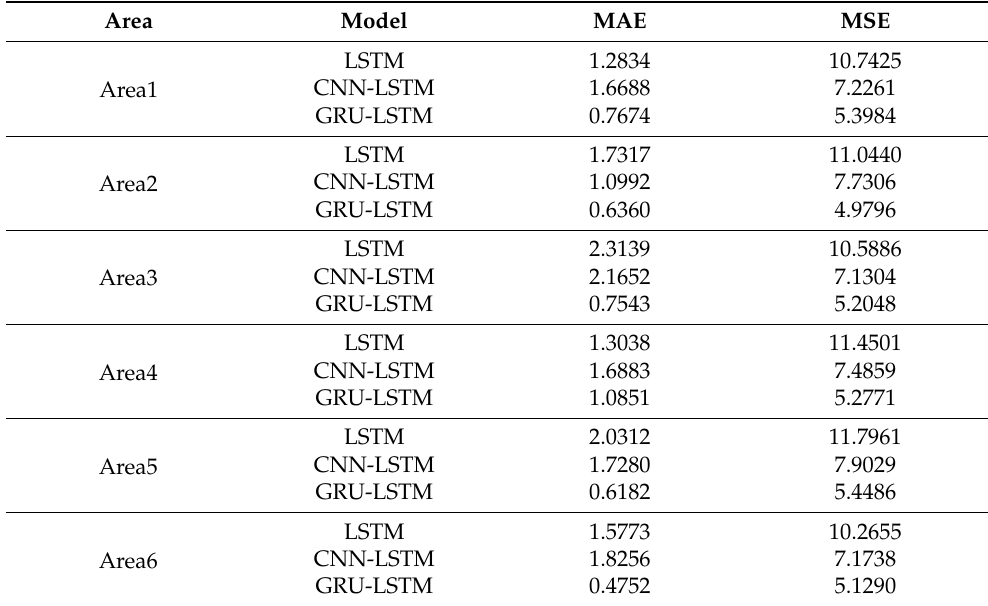
Table 2. 6 areas MAE, MSE of three